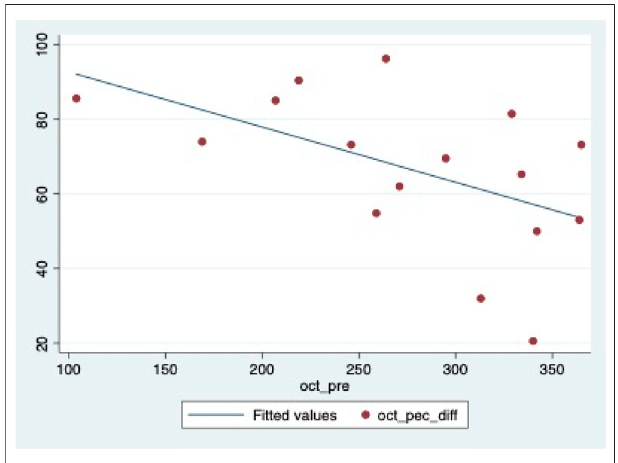
GRAPH 1 | Scattergram representing the association between pre- treatment CT and gain in CT at the end of the treatment.